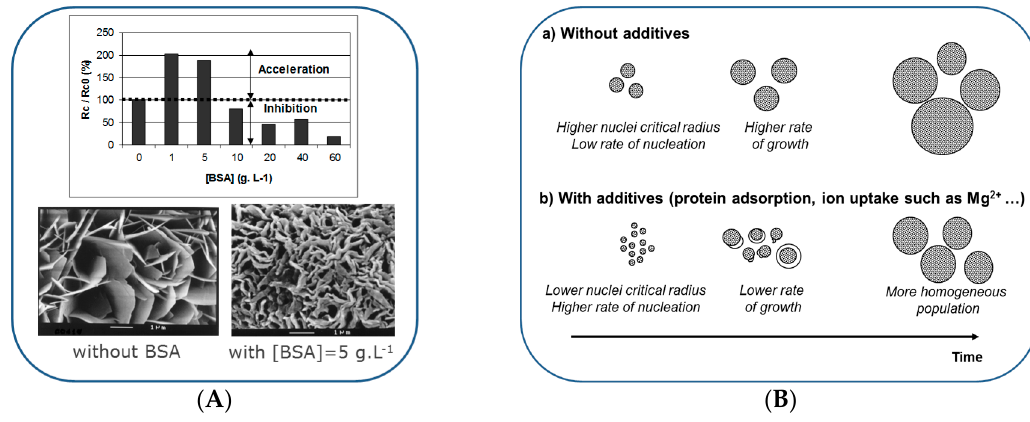
Figure 3. Example of the effect of adsorbed molecules on crystal growth [102,103]. ( A ) Effect of bovine serum albumin (BSA) on octacalcium phosphate crystal growth: kinetics results (relative rate of crystal growth of octacalcium phosphate (OCP) in %) and SEM micrographs of OCP crystal growth on collagen in the presence of various concentrations of bovine serum albumin (BSA) using the constant composition crystal growth technique (adapted from [102,103]). At low albumin